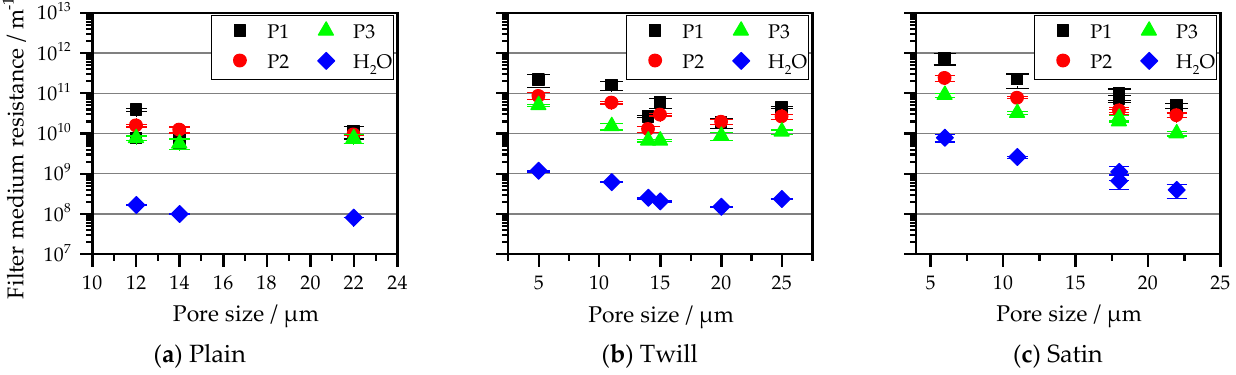
Figure 5. Overview of the tissue resistances for plain ( a ), twill ( b ) and satin fabrics ( c ) in m −1 of the plastic-based monofilament tissues (Table 1) with interaction of the particles from Figure 2.